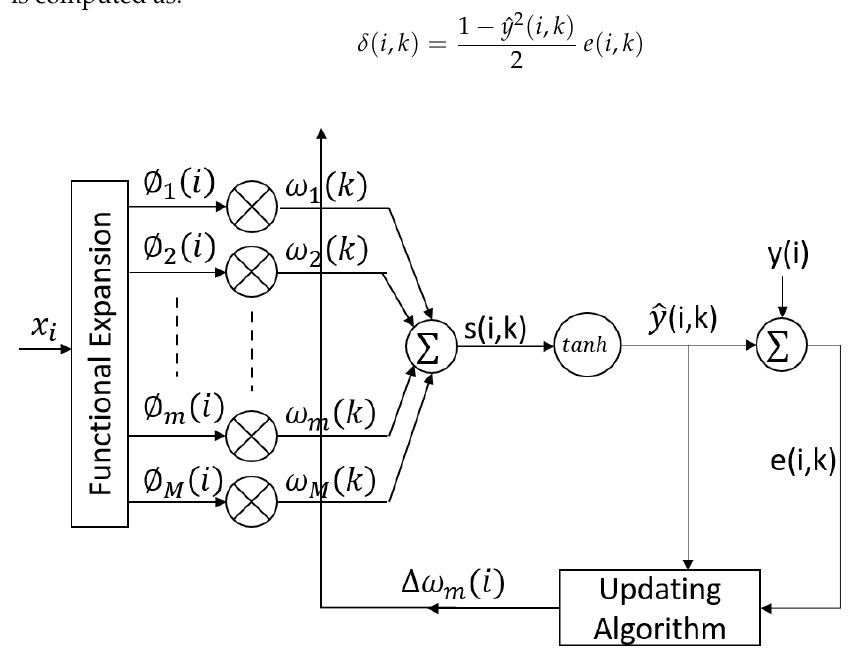
Figure 6. The block diagram of the FLANN